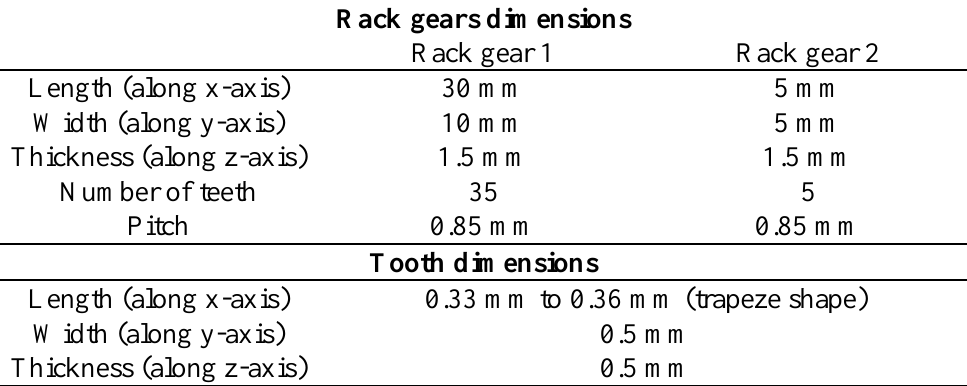
Figure 10. Principle of a linear conveyor based on the digital actuator: ( a ) side view, ( b ) top view, ( c ) picture of the two rack gears. Table 5. Rack gears